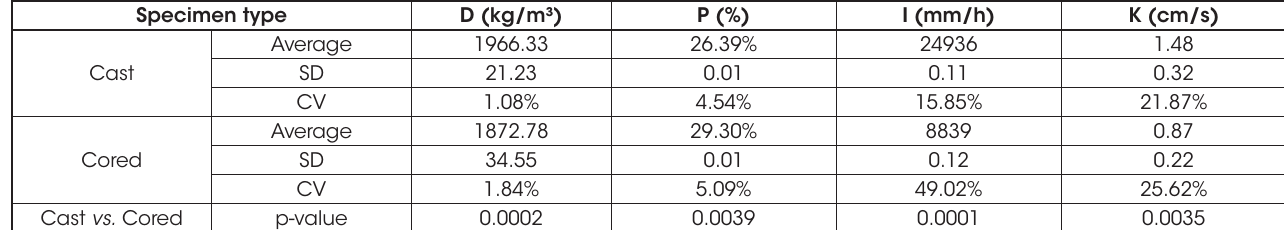
Statistical results for cast and cored specimens (physical and hydraulic properties) Specimen type